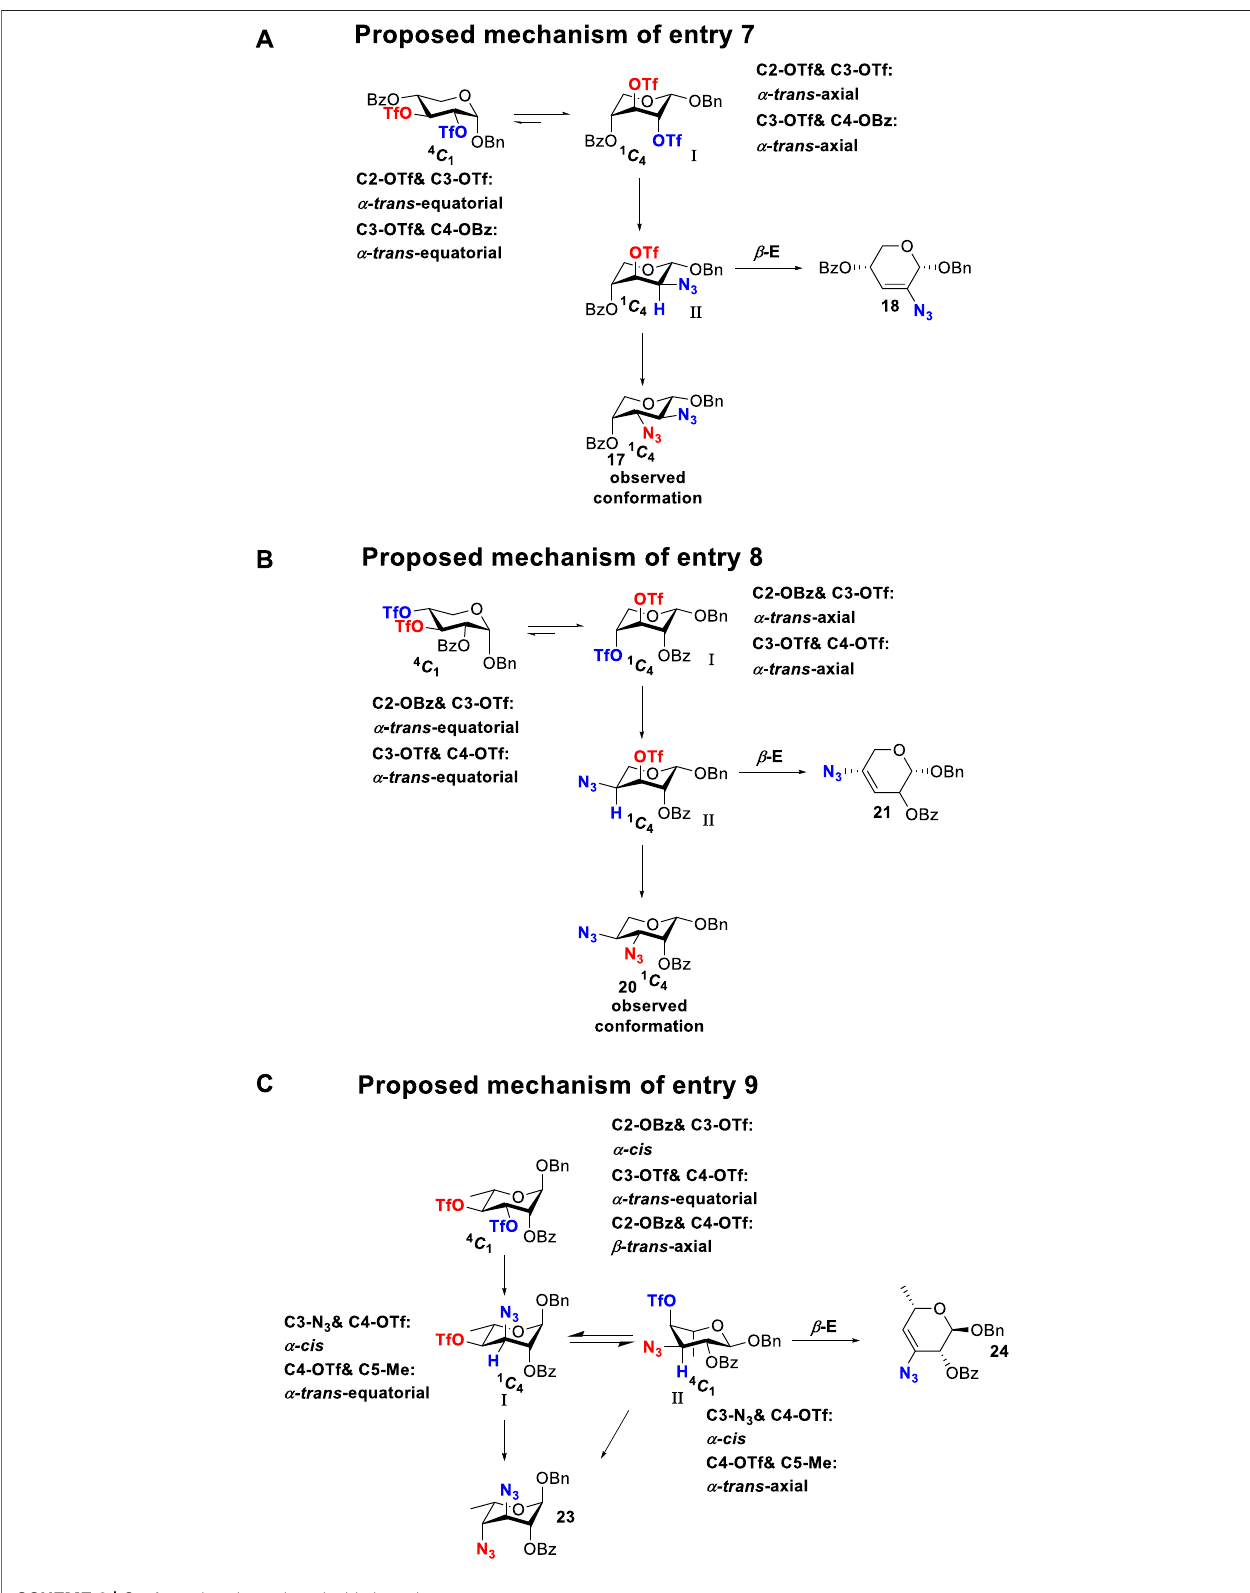
SCHEME 2 | Conformation-dependent double inversion.